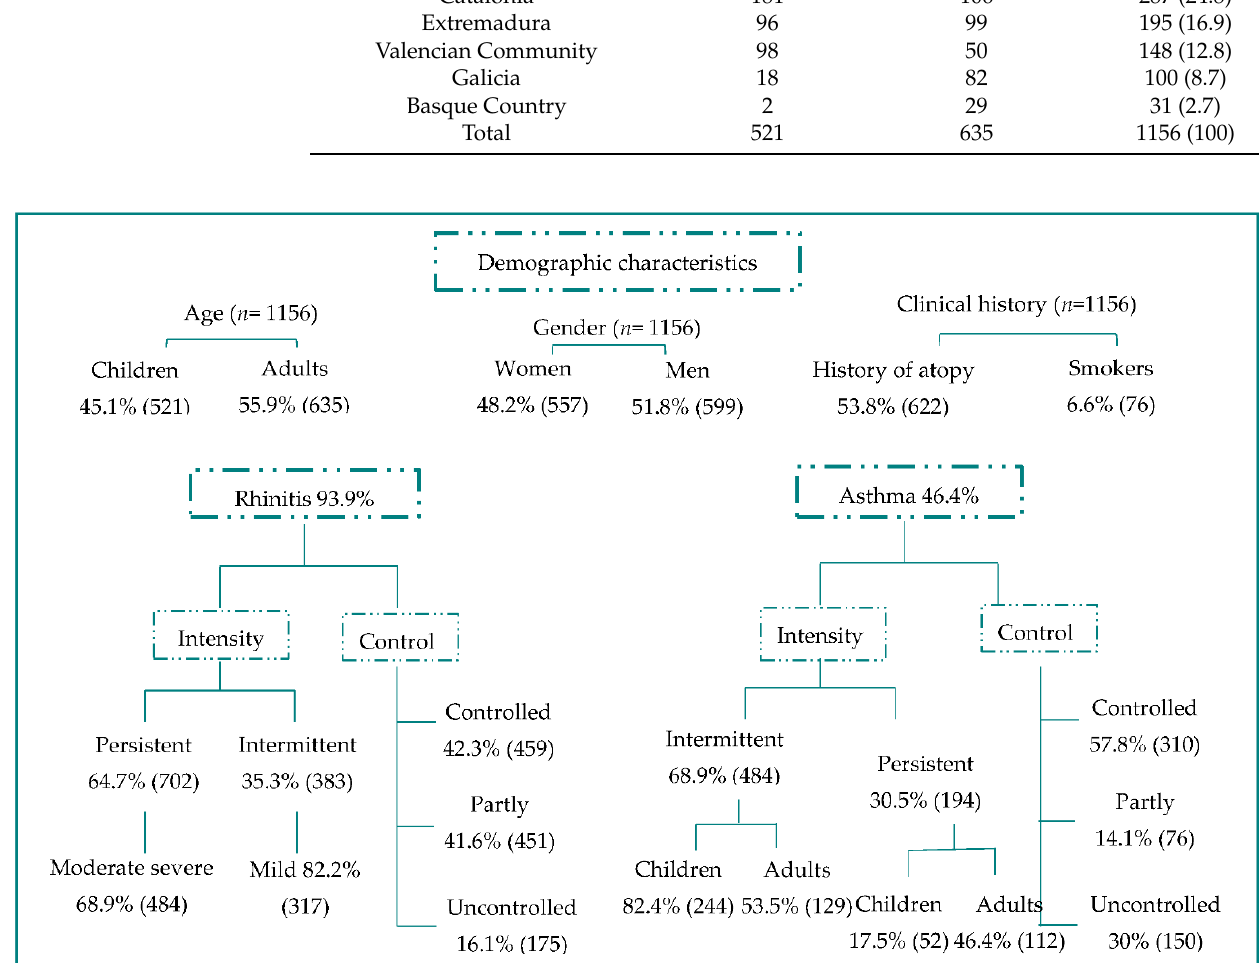
Figure 1. Characteristics of patients included in the study ( n = 1156).